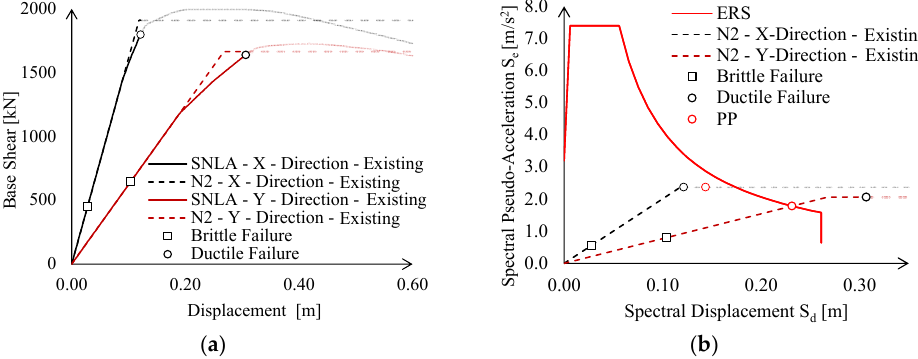
Figure 10. Static non-linear analyses (SLNA) of the existing building in both X- and Y-directions: ( a ) pushover curves and ( b ) ADRS domain checks.